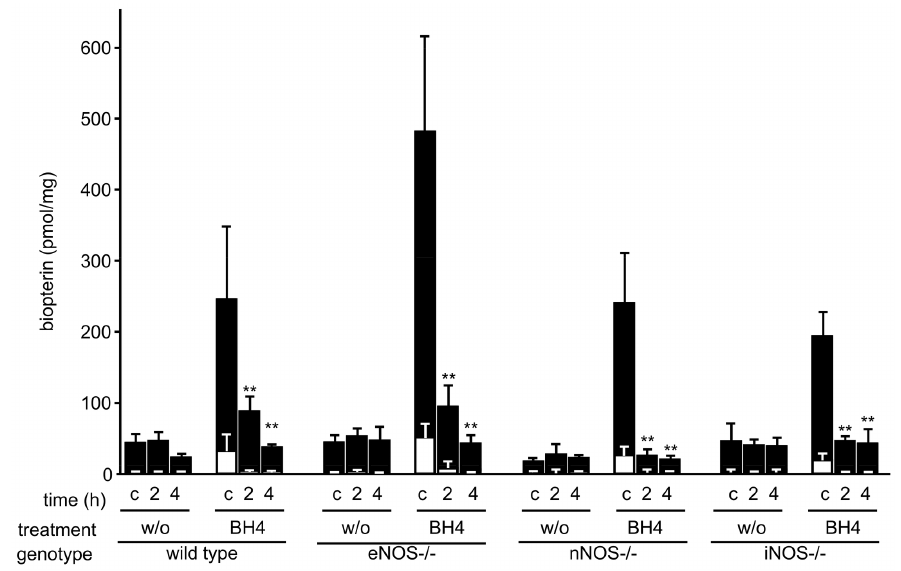
Figure 4. Intragraft biopterin levels in dependence of treatment, donor type and time point. Pancreata were taken from BH4-treated or untreated donors with the indicated genotypes, subjected to ischemia, and transplanted to wt recipients of the same background as the knockouts. Biopterin levels were measured after acidic and alkaline iodine oxidation by HPLC as detailed in the experimental section. Full bars: Tetrahydrobiopterin. Open bars: 7,8-dihydrobiopterin and biopterin. c: non-transplanted controls. 2: grafts following 2 h reperfusion. 4: grafts following 4 h reperfusion. Mean values of 5 animals per group + / 2 SEM are shown. w/o: untreated. Asterisks indicate significant differences between reperfusion time point and the respective non-transplanted control: ** p , 0.01.